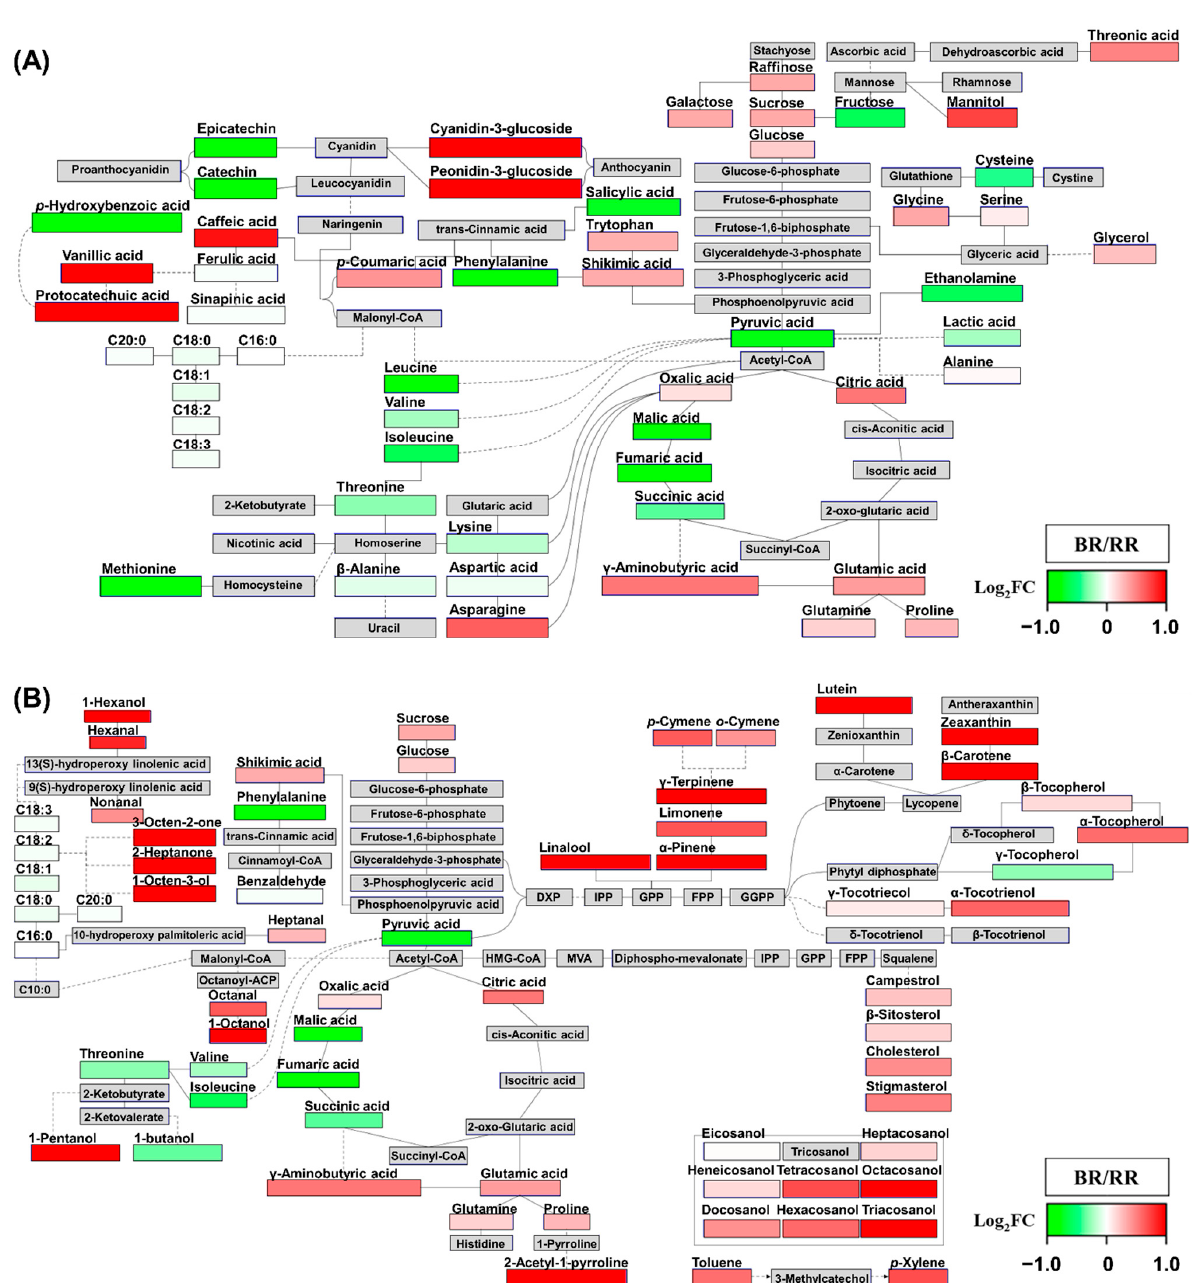
Figure 5. Metabolic pathway diagrams visualized by PathVisio 3. Detailed metabolic pathway diagrams of amino acids, organic acids, sugars, phenylpropanoids, and fatty acids ( A ); terpenoids and volatiles ( B ). The expression data consist of log 2 -transformed fold change (FC) values (log 2 FC). A log 2 FC value range is − 1 < log 2 FC < 1. If log 2 FC value is higher than zero (indicated in red), metabolite content is higher in black rice than in red rice. If log 2 FC value is less than zero (indicated in green), metabolite content is higher in red rice than in black rice. If log 2 FC value is zero (indicated in white), metabolite content is identical in black and red rice. (BR: Black Rice, RR: Red Rice).